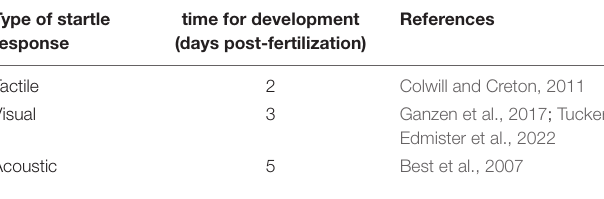
TABLE 4 | Type of different startle responses and their time of